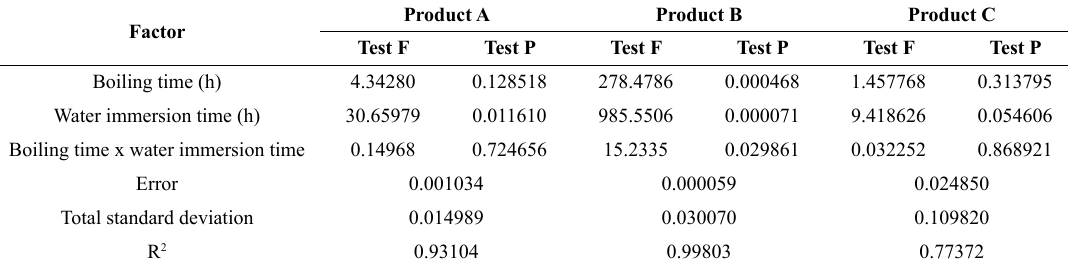
Table 3. Analysis of variance (ANOVA) applied to the WA values in relation to the boiling time and water immersion time.